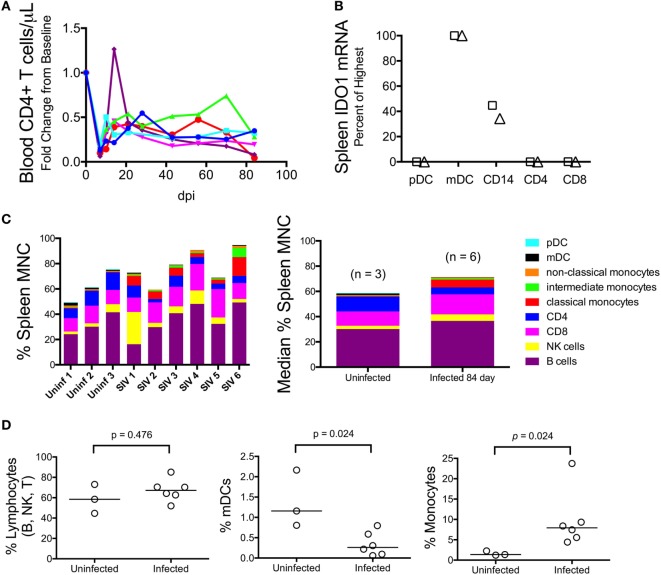
Myeloid dendritic cells (mDCs) express the highest levels of IDO1 mRNA in chronically SIV-infected macaque spleen. (A) Absolute CD4+ T cell counts in the blood were measured longitudinally using complete blood count and flow cytometry in five animals to confirm immune suppression. (B) Cells were teased out of spleen tissue from two animals (designated as the triangle and square, respectively) at 84 days p.i., then sorted by fluorescence-activated cell sorting to separate pure populations of pDCs, mDCs, CD14+ monocyte/macrophages, CD4+ T cells, and CD8+ T cells. mRNA was extracted from the isolated cells and analyzed for IDO1 expression levels. All data were normalized to internal GAPDH housekeeping mRNA and then to the highest expressing cell type, which was the mDC population in both samples, by the 2−ΔΔCt method. Fold change data were transformed to a percentage of the mDC values. Similar results were obtained with normalization to 18S ribosomal RNA. (C) Mononuclear cells from all five chronically infected animals as well as three uninfected controls were analyzed by an extensive flow cytometry panel for various cell markers. Raw cell percentages are depicted in the left-most panel; median cell percentages are shown in the panel on the right. (D) Specific populations of cells were further analyzed by Mann–Whitney test to determine statistical significance.